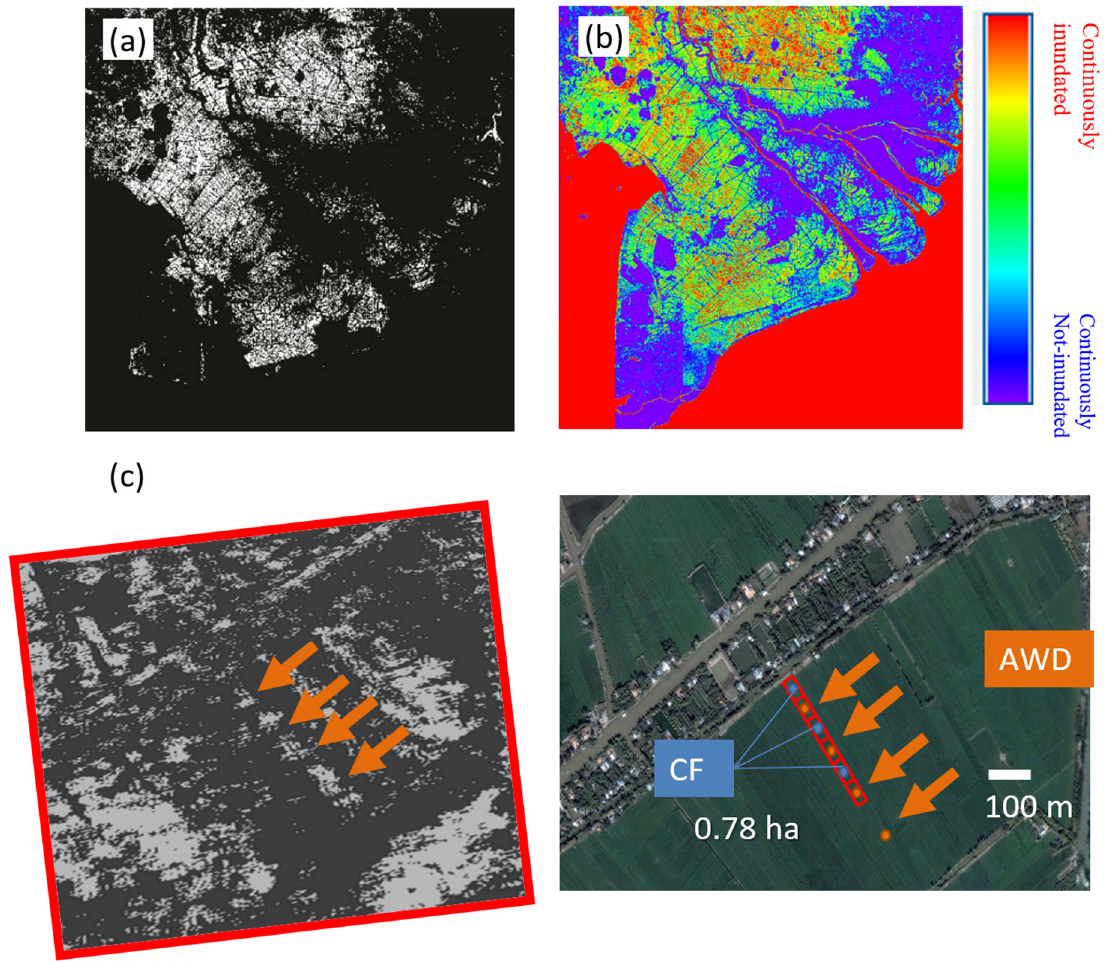
Figure 8. PALSAR-2 data-based rice map (( a ); white pixels indicate rice paddies), PALSAR-2 data- based rice floodability map ( b ) and inundation detection snapshot obtained by PALSAR-2 above one of the study sites [Thot not, Can Tho city, Vietnam, on 6 May 2016 (69 days after sowing)] with the corresponding aerial photo ( c ); CF: Continuously inundated paddy; AWD: Alternate wetting and drying paddy; the temporal water level dynamics of these blocks are presented in the referenced literature [21,26,27]).